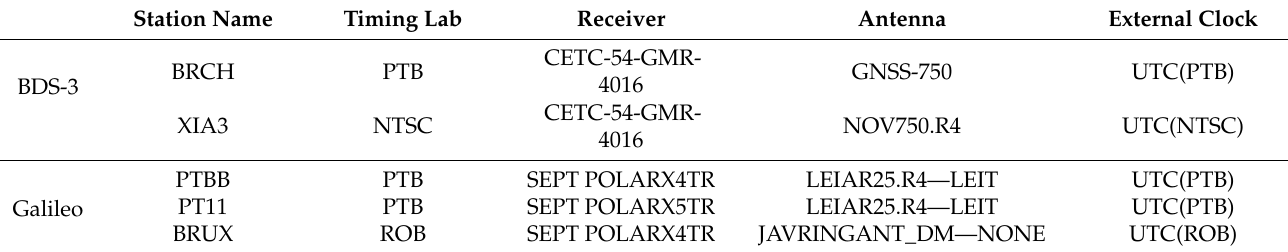
Table 3. Information for selected station from timing